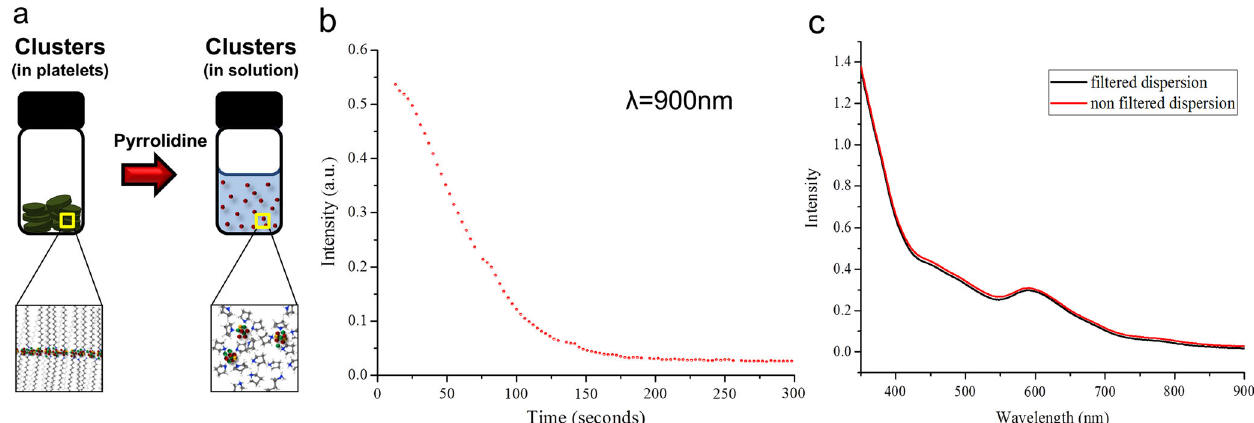
Fig. 4 Scheme of the platelets solution in pyrrolidine ( a ). Evolution of the intensity of the absorbed light ( λ = 900 nm) with time for a mixture of platelets in IPA and pyrrolidine ( b ). The extinction intensity was measured every 3 s. The UV – vis spectra of the sample before and after the fi ltration through a fi lter with a pore size of 20 nm is shown in ( c Fig. 5b – d) or agglomerate and precipitate (as observed when